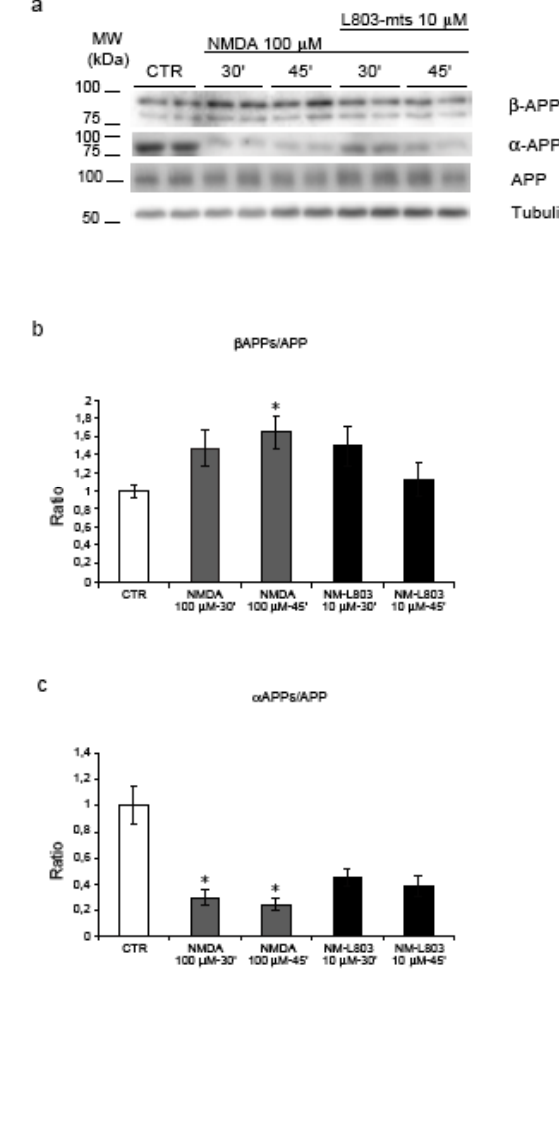
Figure 3. Inhibition of GSK-3 β and APP amyloidogenic processing. ( a) NMDA induces an increase in the APP amyloidogenic processing as shown by the increase of β APPs and the decrease of α APPs fragments. (b) Quantification showed a significant increase of β APPs/APP ratio during NMDA-45’ treatment (p = 0.02) in comparison to untreated controls. L803-mts/NMDA-45’ treatment reduced β APPs levels, this reduction is not significant compared to NMDA-45’ treatment. (c) NMDA reduced the α APPs/APP ratio at 30’-45’ (p = 0.037, p = 0.039) compared to untreated controls. Instead, L803-mts induced an increase of the α APPs/APP ratio, although it was not able to restore control levels. Loading control: Tubulin. Quantifications are from three independent experiments (±S.E.M.), * p <